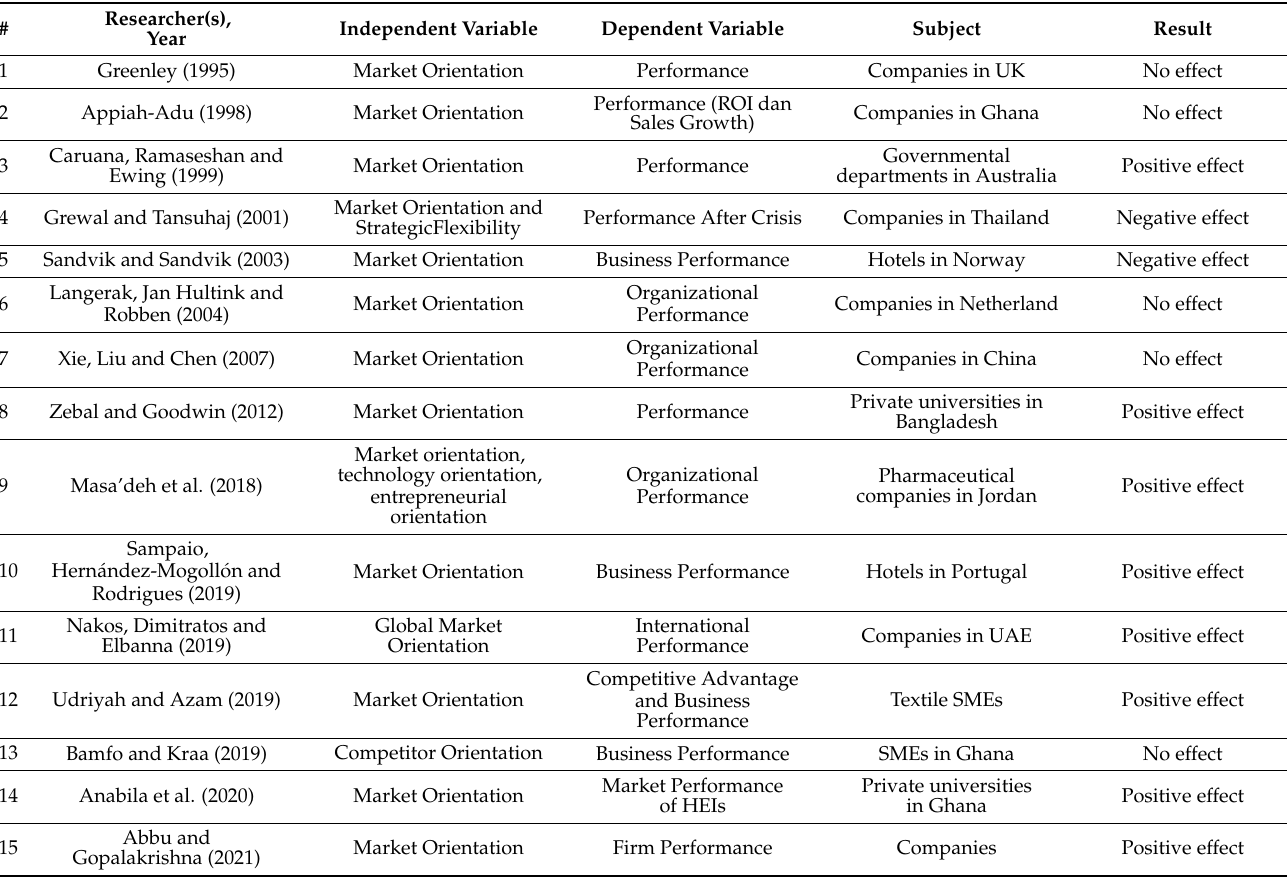
Table 1. Map of some previous